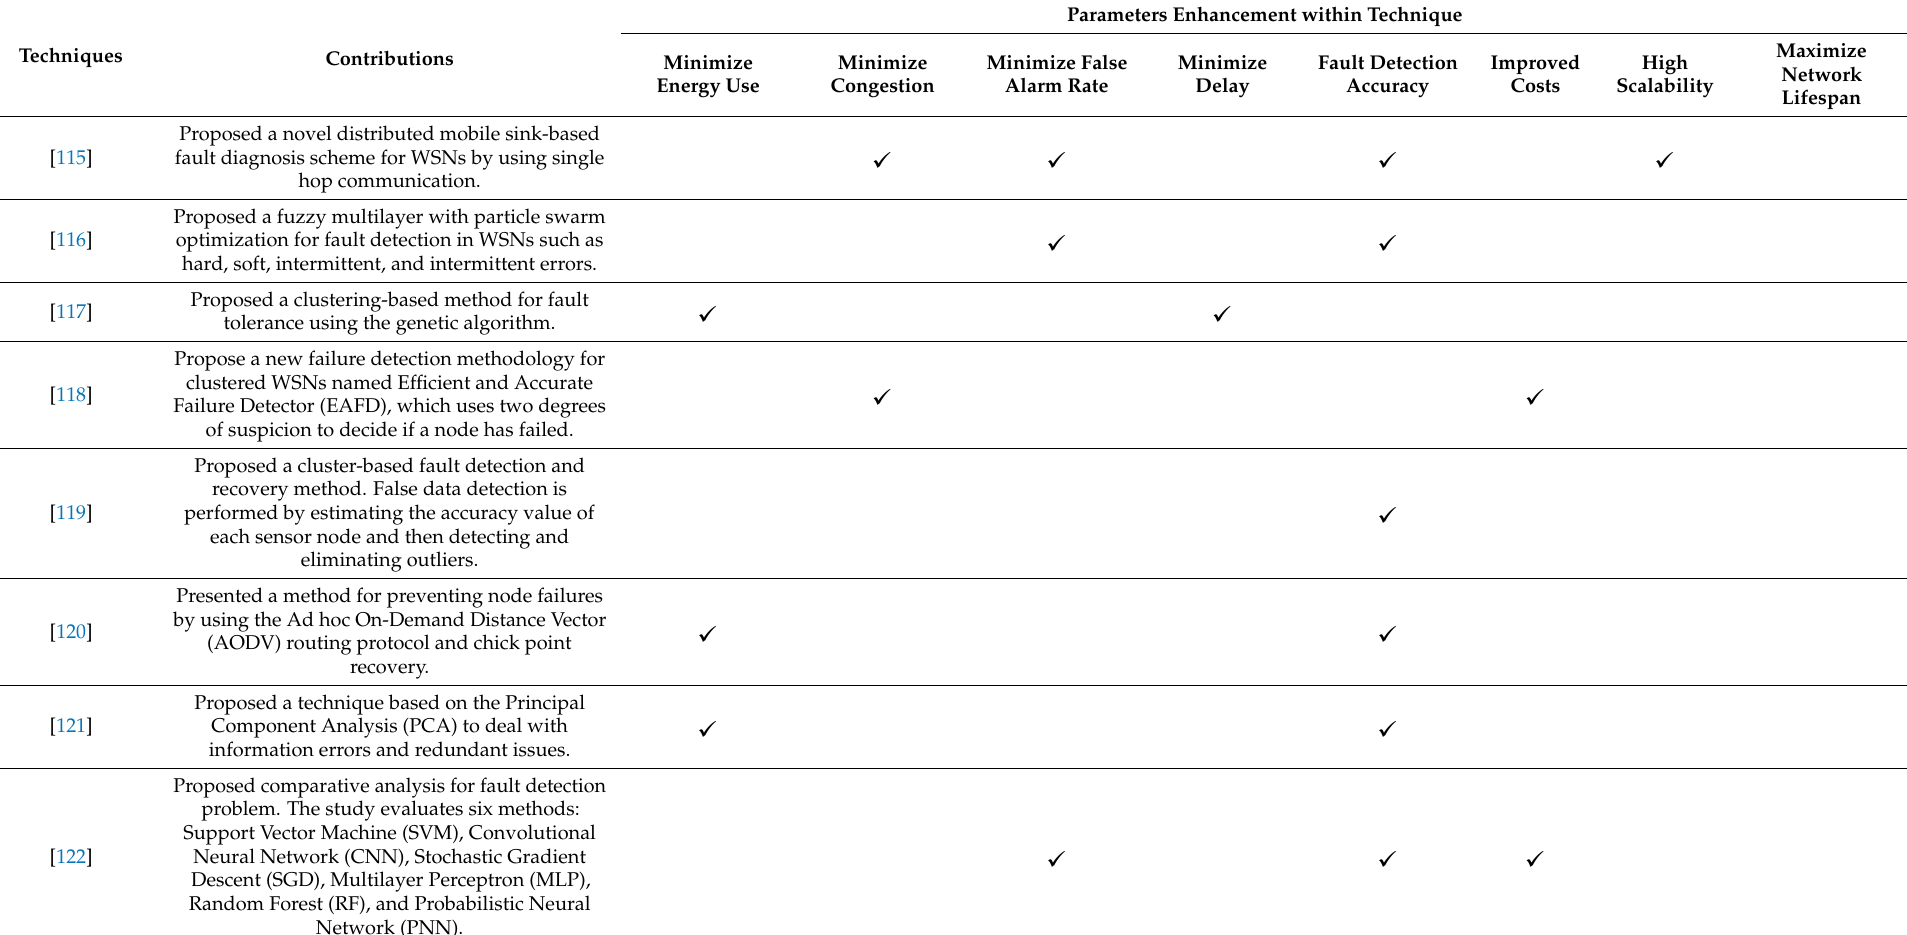
Table A1. Cont. Table 1. Surveys on Fault-Tolerant in WSNs.